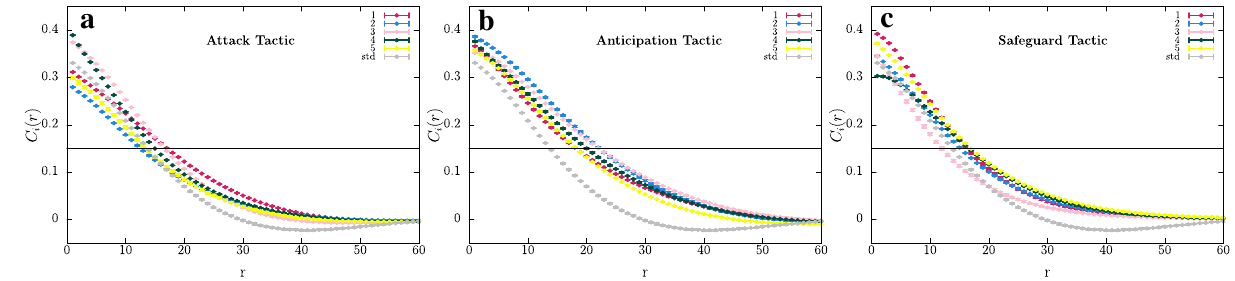
Figure 5. Autocorrelation functions C i . The colours follow the scheme in Fig. 1. ( a ), ( b ) , and ( c ) depict the cases where individuals of species 1 use Attack, Anticipation, and Safeguard tactics, respectively. Grey circles show the results for the autocorrelation function for the standard model (std), that is the same for every species. The error bars indicate the standard deviation. The horizontal black line indicates the threshold assumed to calculate the characteristic length. The results were obtained using R = 3 and s = r = m = 1 / 3 Initially, individuals of all species are distributed aleatorily on the grid. Because of the random initial condi- tion, selection interactions are frequent in the initial stage of the simulation. The result is the formation of spirals whose adjacent arms are mostly occupied by individuals of species that do not select each other. In the standard model, the spirals are symmetric (Fig. 2a), leading to a cyclic territorial dominance of the species (Fig. 3a) and selection risks (Fig. 4a). This symmetry is broken if individuals of species 1 perform a directional movement tactic. Firstly, if the individuals of species 1 use the Attack tactic, they have more chances of selecting because they move towards the direction with more individuals of species 2 - even though the selection probability s is the same for all species. The higher selection rate for species 1 is responsible for the alternating territorial dominance